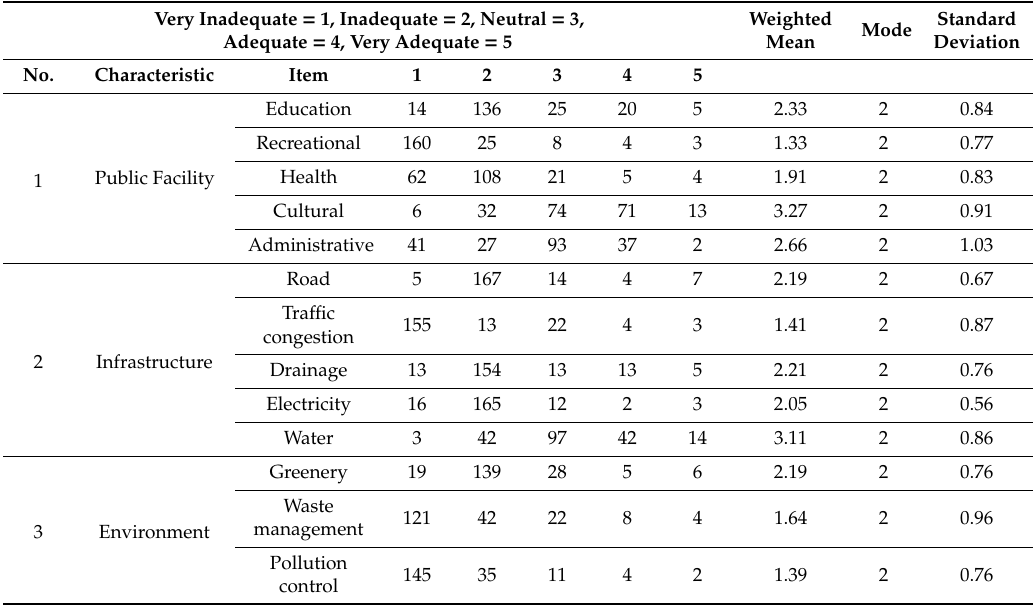
Table 2. Infrastructure, facilities, and environmental adequacy survey in Kabul City Study area (based on author’s 2018